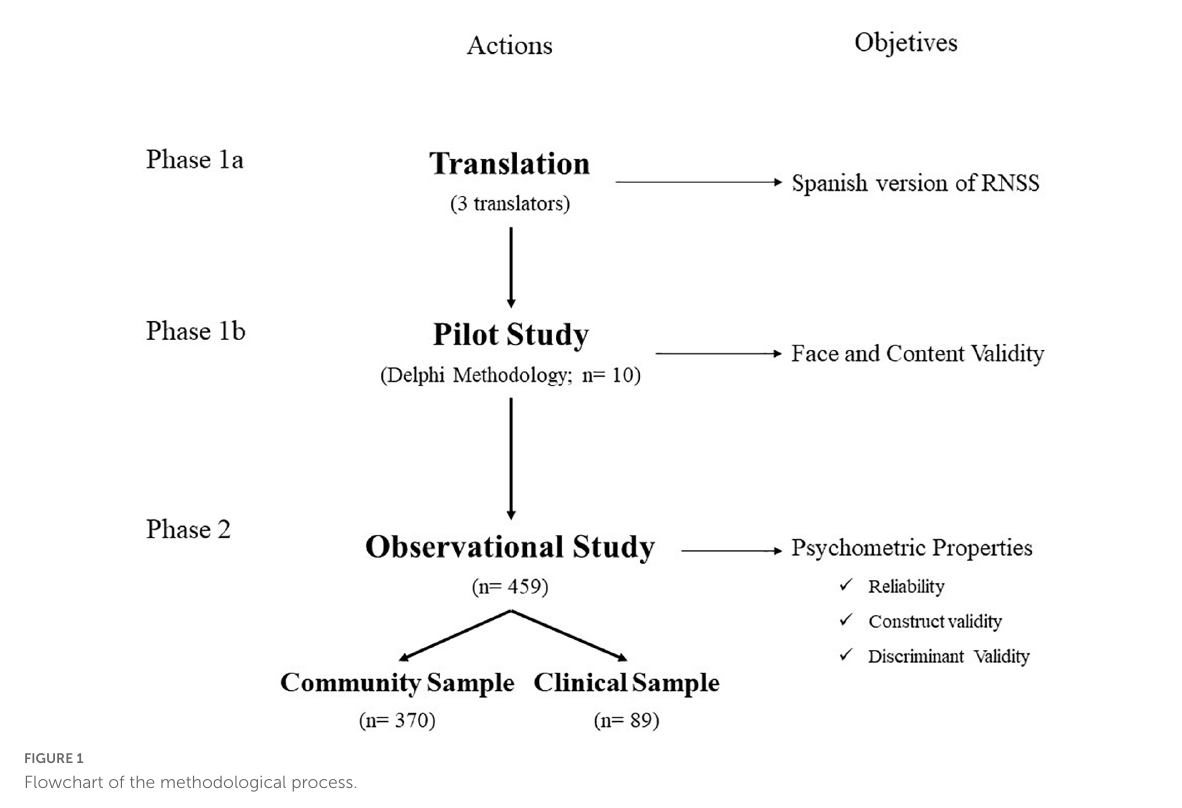
FIGURE1 Flowchart of the methodological